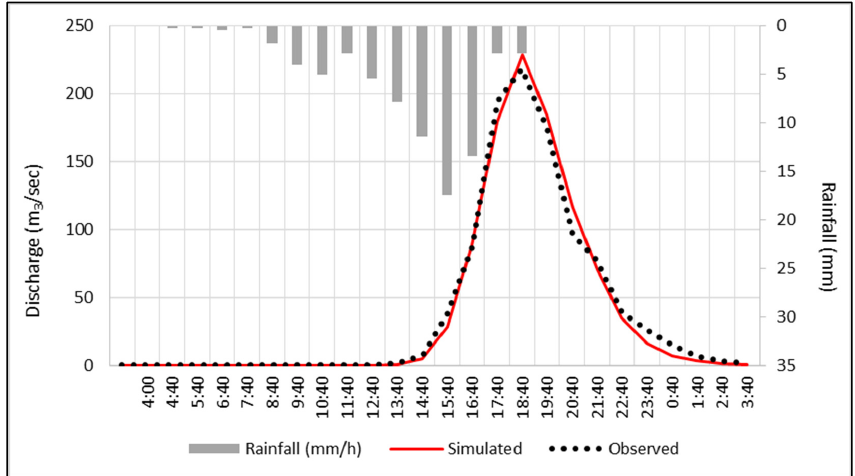
Figure 13. Observed and simulated (after the model calibration) hydrographs of the October 2010 flood event at Vatonias stream.